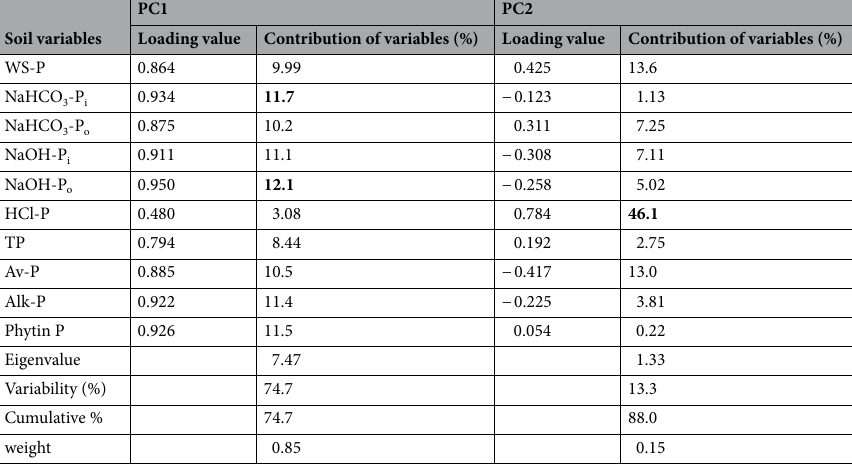
Table 5. Loading values and percent contribution of assayed soil variables at surface soil layer on the axis identified by the principal component analysis. WS-P Water soluble phosphorus, NaHCO 3 -P i Sodium bicarbonate inorganic phosphorus, NaHCO 3 -P o Sodium bicarbonate organic phosphorus, NaOH-P i Sodium hydroxide inorganic phosphorus, NaOH-P o Sodium hydroxide organic phosphorus, HCl-P Hydrochloride phosphorus, TP Total phosphorus, Av-P Available phosphorus, Alk-P Alkaline phosphatase.